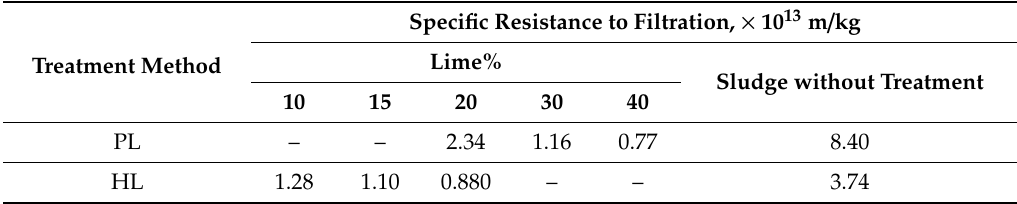
Table 2. Resistivity of sludges treated with powdered lime (PL) and hydrated lime (HL).